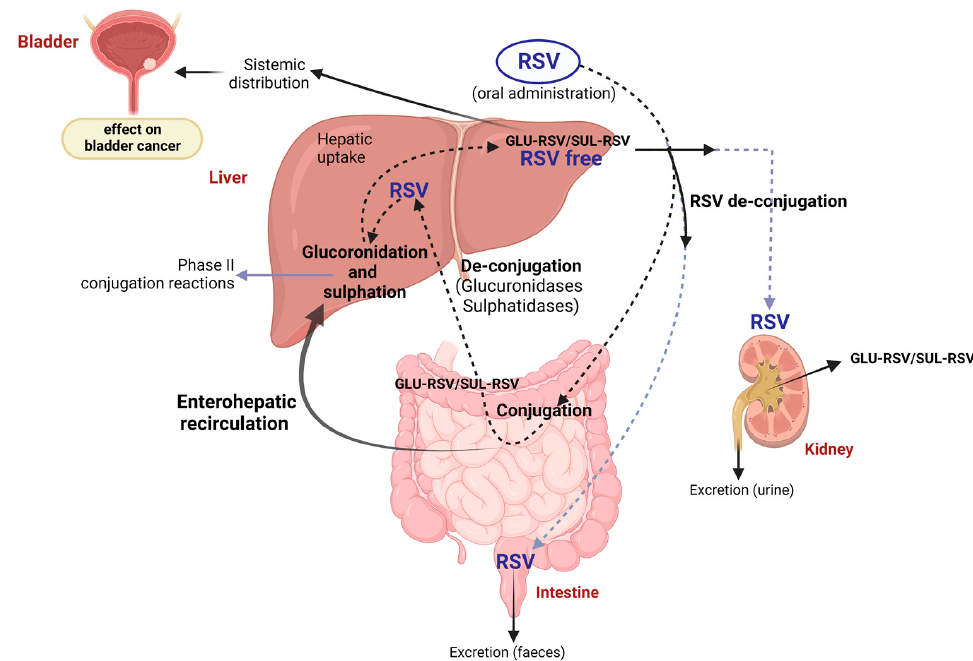
Figure 3. Metabolism and biotransformation of resveratrol in different organs. Resveratrol undergoes conjugation with uridine diphosphoglucuronic acid (UDP-GA, indicated as GLU-RSV in the figure) or 3 ′ -phosphoadenosine-5 ′ -phosphosulphate (PAPS, SUL-RSV indicated as SUL-RSV in